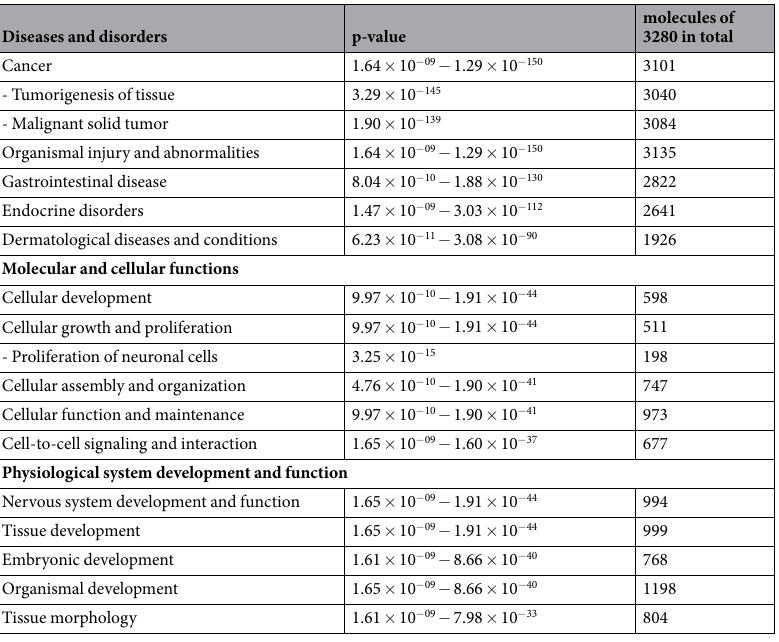
Table 2. Top diseases and functions of significant differentially expressed genes in untreated peritumoral brain vs. GBM